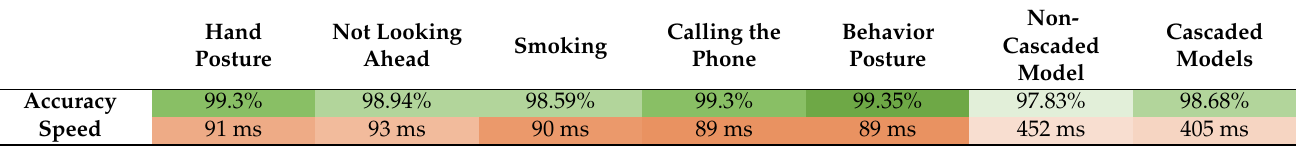
Table 4. Comparison of cascaded models and non-cascaded model for daytime data